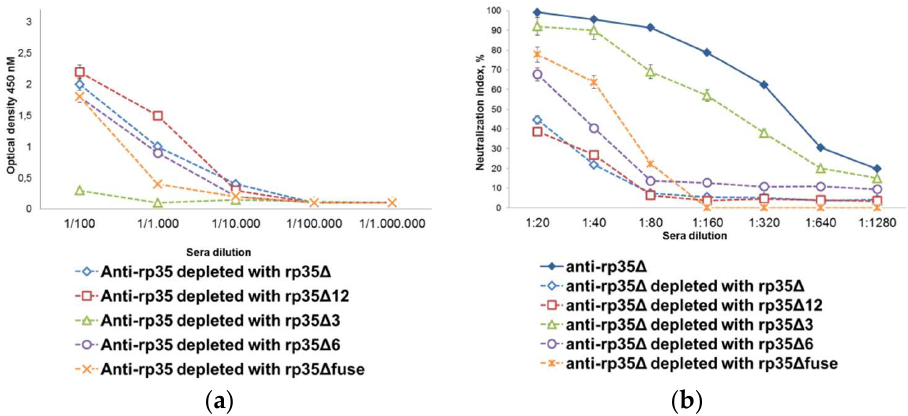
Figure 4. Characterization of pooled anti-rp35 ∆ sera after depletion. ( a ) Indirect ELISA evaluating binding of depleted anti-rp35 ∆ sera with the corresponding depletion antigen; ( b ) in vitro neutraliza- tion of VACV with serial dilutions of pooled anti-rp35 ∆ sera depleted with rp35 ∆ , rp35 ∆ 3, rp35 ∆ 6, rp35 ∆ 12, and rp35 ∆ fuse. The initial dilution of sera was 1:20. VACV was diluted to 320 pfu/mL. The data from three or more independent experiments are